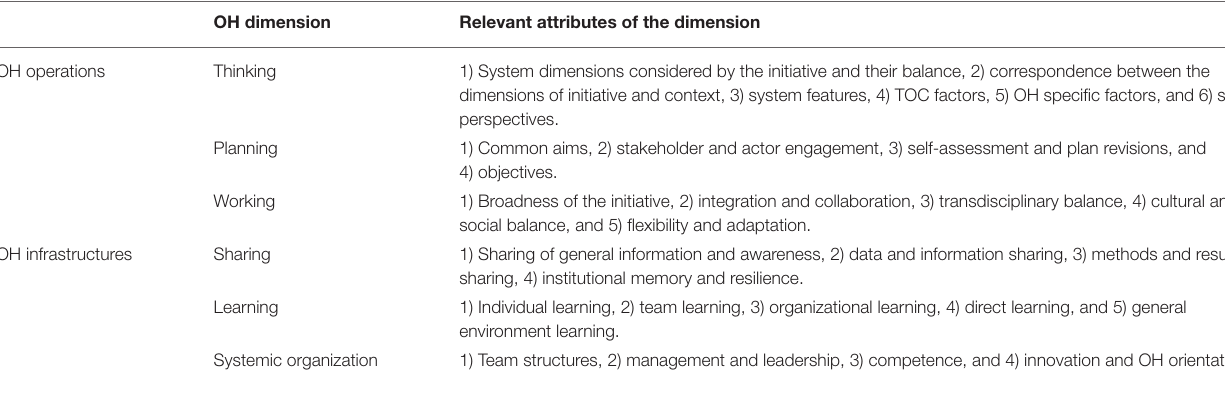
TABLE 1 | OH dimensions and their articulation. OH dimension Relevant attributes of the dimension Thinking 1) System dimensions considered by the initiative and their balance, 2) correspondence between the dimensions of initiative and context, 3) system features, 4) TOC factors, 5) OH specific factors, and 6) social